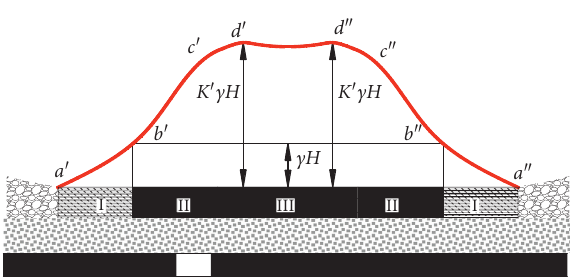
Figure 10: Diagram of the nonuniform stress distribution on the coal